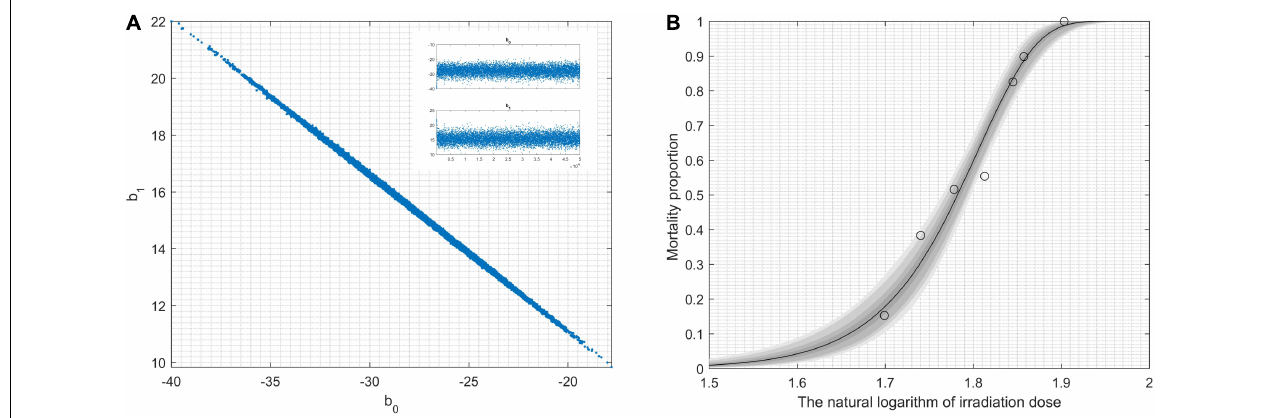
FIGURE 1 | Results obtained by modeling lethality-associated a function of irradiation-dose, and applied delayed-rejection adaptive metropolis Markov chain Monte Carlo chain (MCMC). (A) 2D MCMC-chain using 5.0 × 10 4 consecutive steps of delayed-rejection adaptive metropolis MCMC. Top right figures: the 1D parameter chains. (B) The model fit randomly selected the chain subsets, and the model-predictive envelope was developed. The gray protection system of the plot corresponds to 50, 90, 95, and 99% posterior